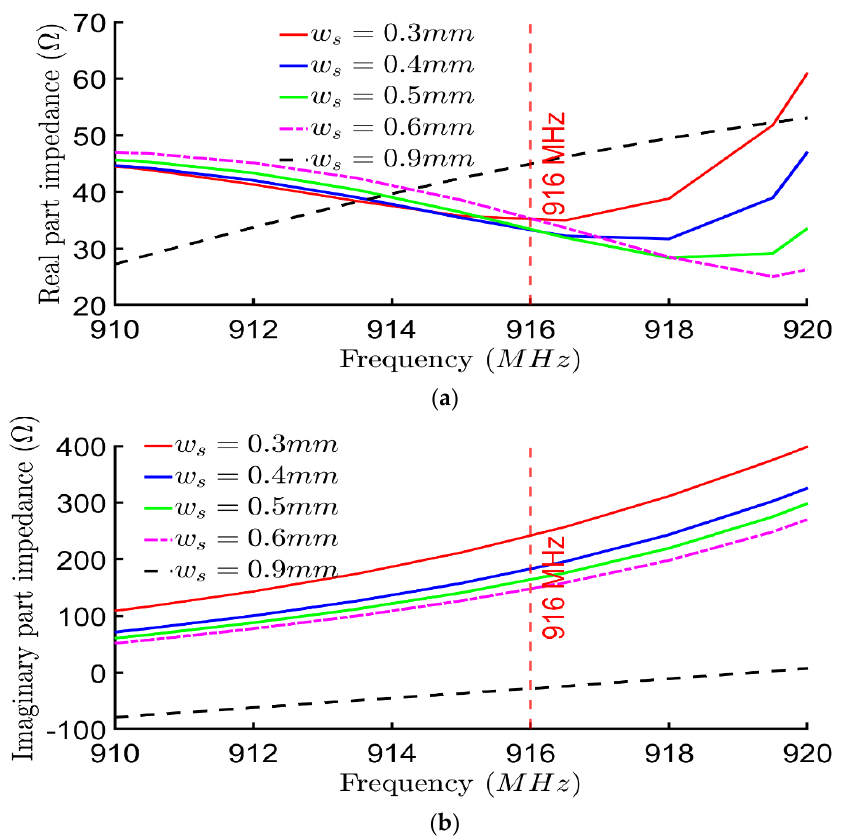
Figure 10. Proposed structure impedance vs. different stub width w s : ( a ) Real part variation of the impedance; ( b ) Imaginary part variation of the impedance.